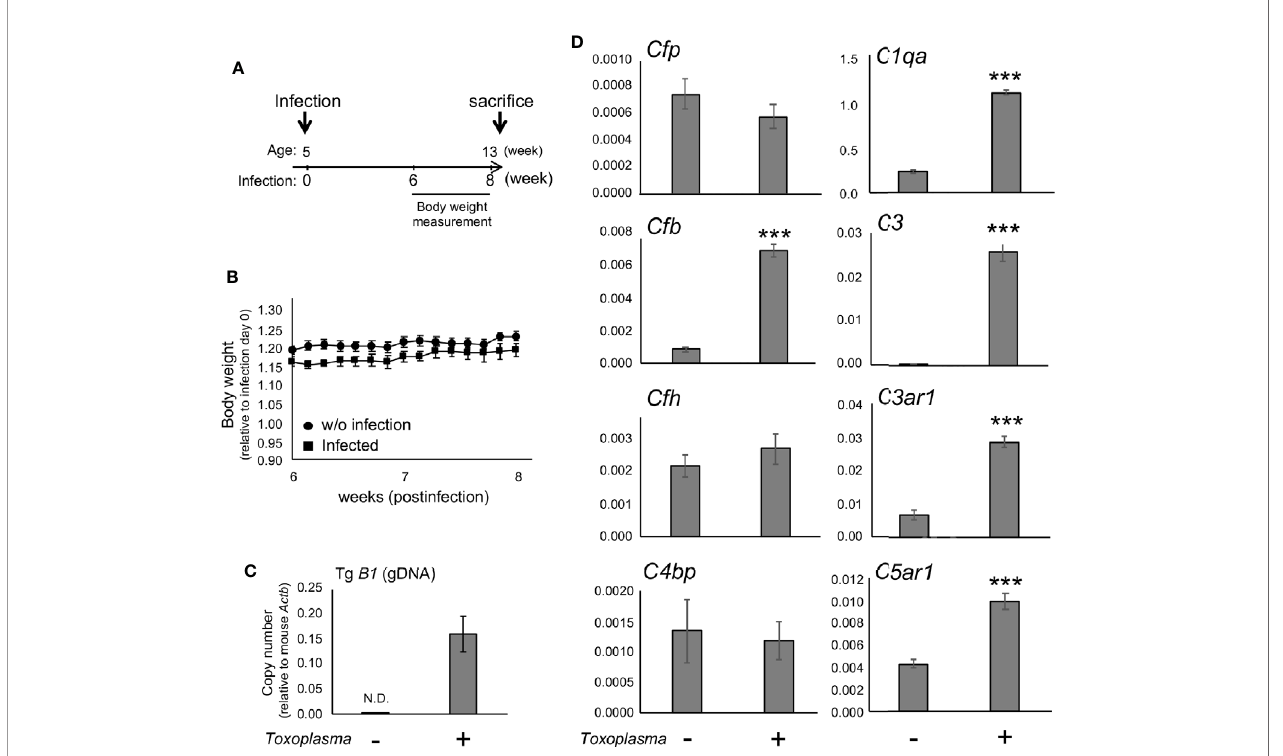
FIGURE 2 | mRNAs for factor B and anaphylatoxin receptors are persistently upregulated after Toxoplasma infection. (A) C57BL/6J were divided into two groups: with (n=4) or without infection (n=4). The infection group received oral inoculation of T. gondii (Fukaya, three cysts) at the age of 5 weeks. (B) Body weight was measured before inoculation and from week 6 to week 8 until sacri fi ce. Body weight change from week 6 to week 8. Data are presented as means ± SEM. (C) T. gondii gDNA levels were quanti fi ed by qPCR. Values were normalized to mouse b -actin ( Actb ). Data are presented as means ± SEM. (D) mRNA levels for complement components (properdin: Cfp , factor B: Cfb , factor H: Cfh , C4b-binding protein: C4bp , C1q: C1qa , C3: C3 , C3aR: C3ar1 , and C5aR1: C5ar1 ) in the cortex. Data are presented as means ± SEM. *** p < 0.001 (Student ’ s t-test vs. control). The representative outcome of two independent experiments are presented.